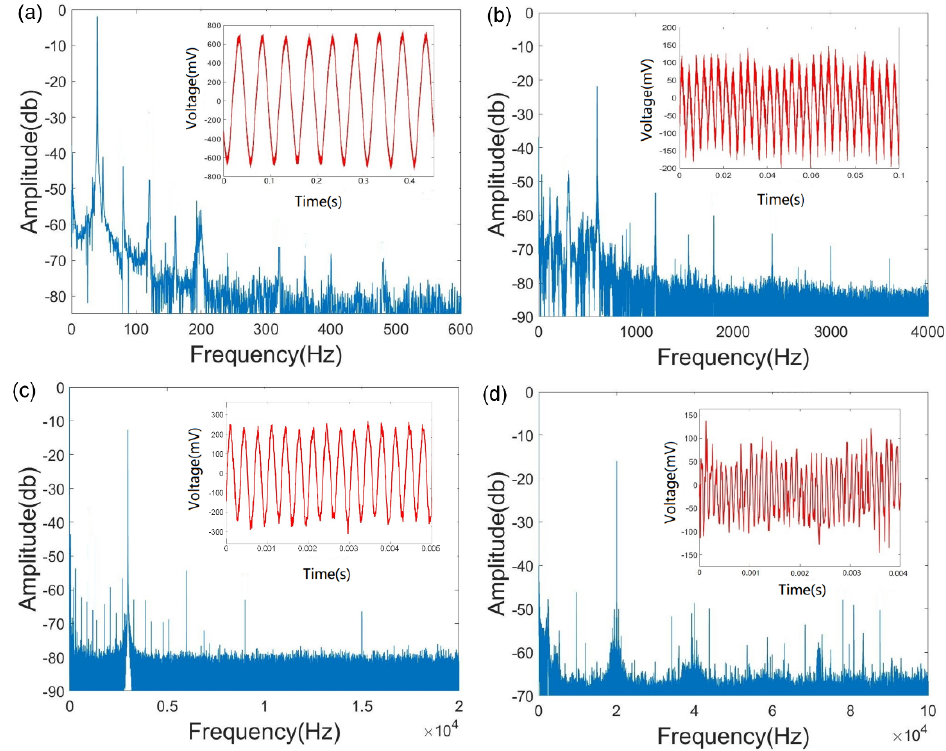
Figure 11. ( a – d ) Time-domain and frequency-domain diagrams of the sensor at frequencies of 30 Hz, 600 Hz, 3000 Hz, and 20,000 Hz, respectively.